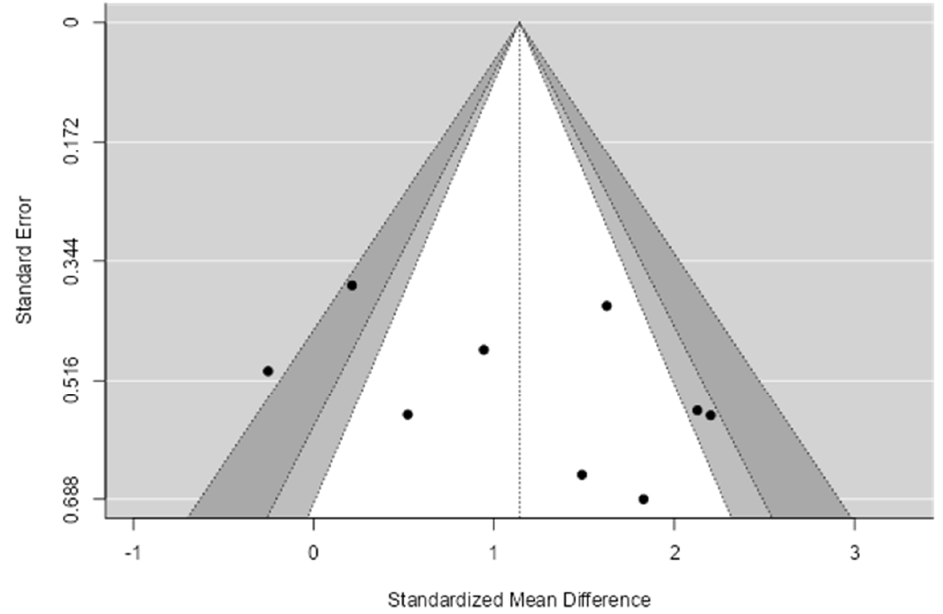
Figure 3. Funnel plot for evaluating publication bias in included studies examining HIIT in hypoxia and the effect on VO 2max .